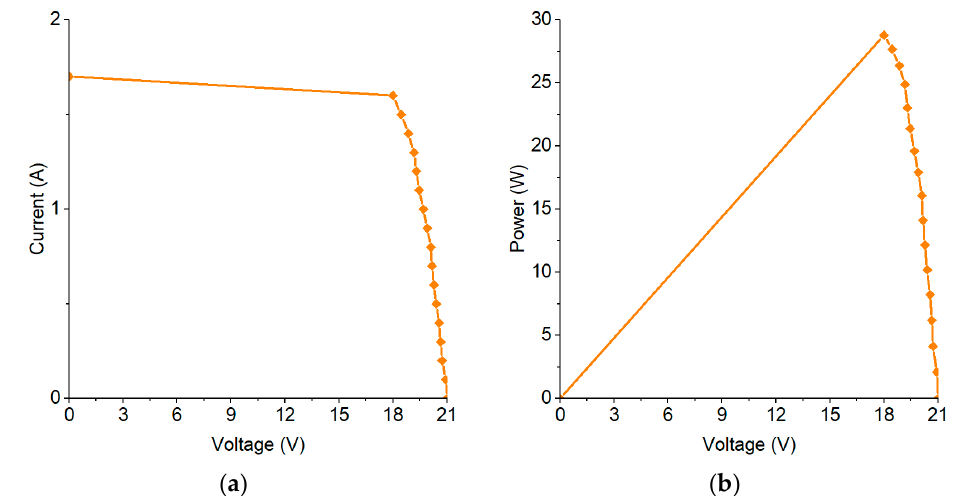
Figure 10. Temperature distribution on the front side of the 50 Wp PV panel after 15 min of the experiment (when dedicated water cooling system was used).